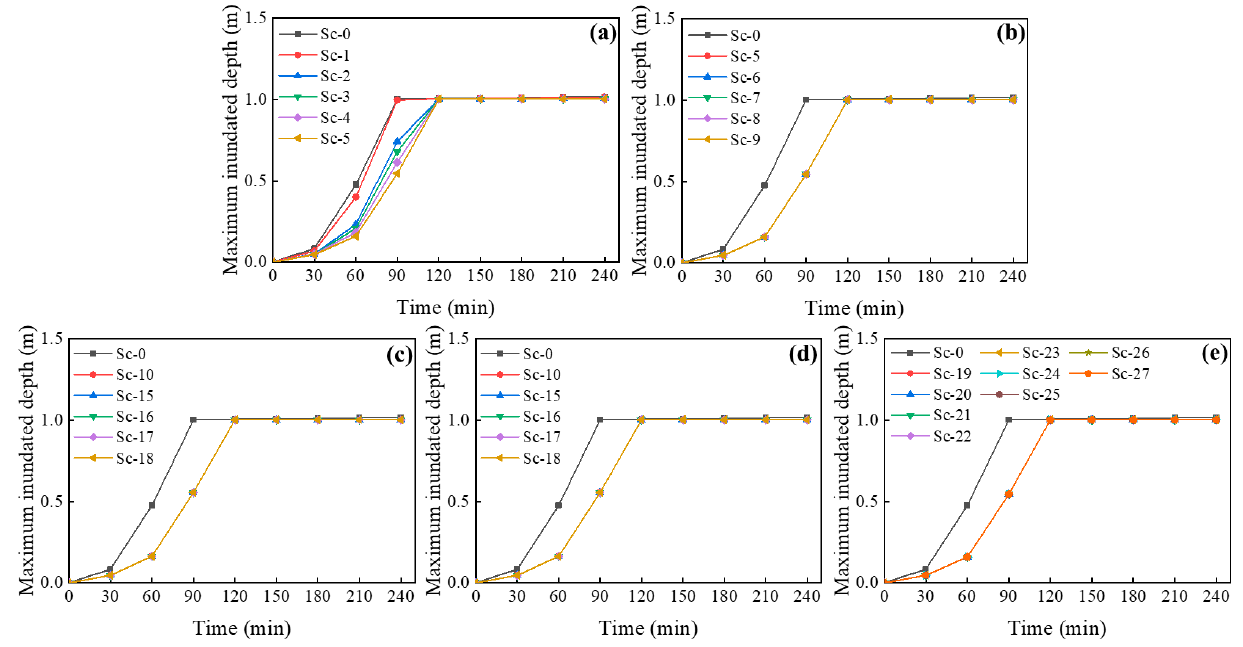
Figure 22. The time series plot of MID in 3 h event in considered scenarios of ( a ) connectedness of GR; ( b ) connectedness of RG; ( c ) edge density of GR; ( d ) edge density of RG; ( e ) flow distance of RG.